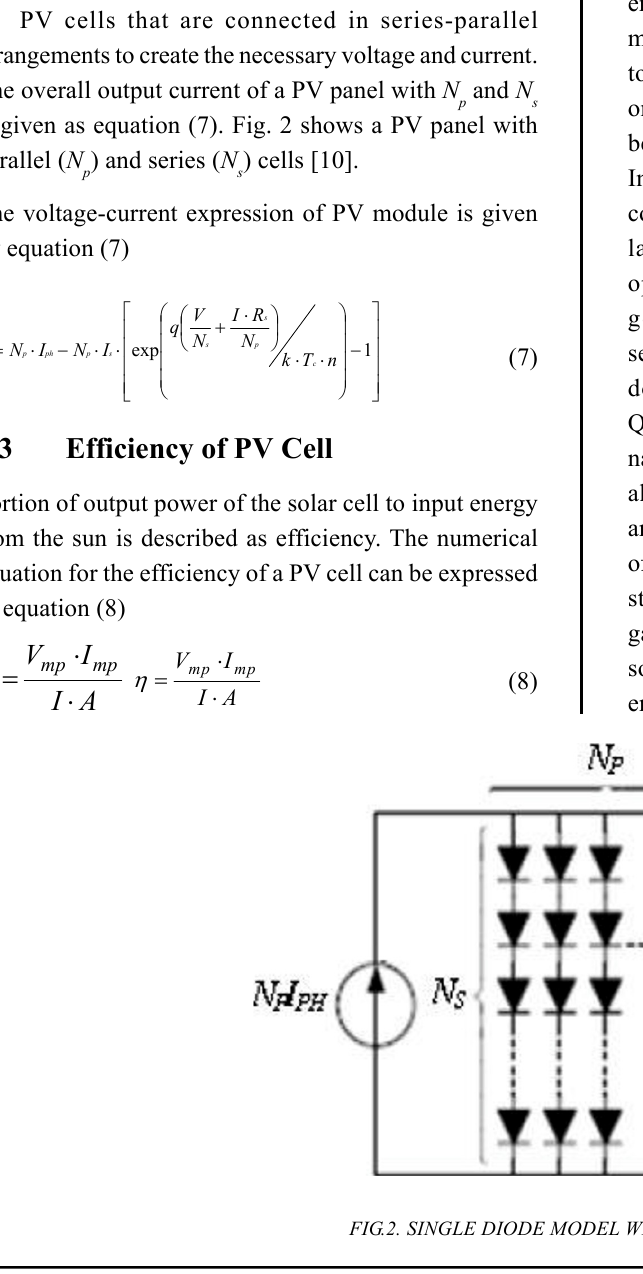
FIG.2. SINGLE DIODE MODEL WITH N